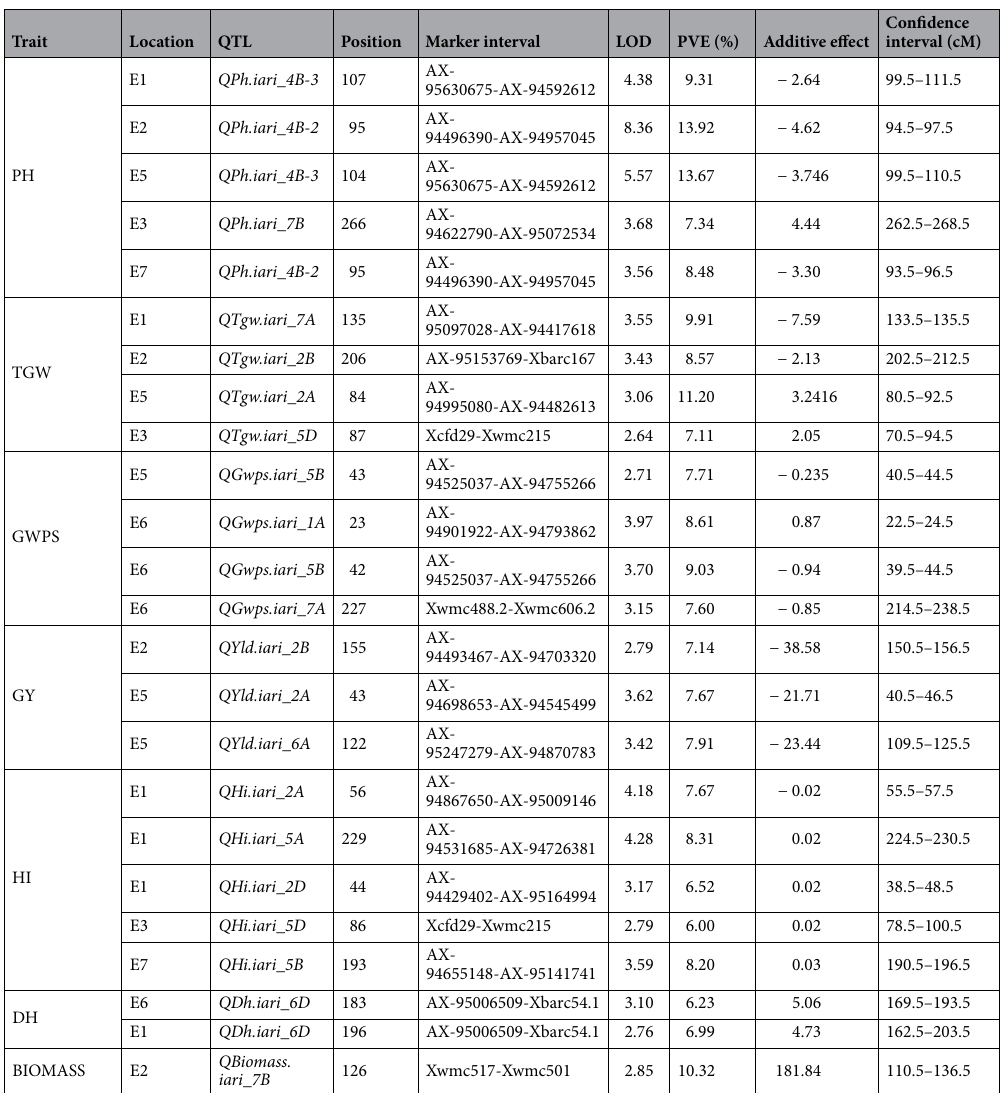
Table 2. QTLs detected for various physiological and yield component traits in the HD2733/2*C306 backcross inbred lines population. Confidence interval (cM), Position of QTL located on chromosome: as cM distance from the top of each map. LOD, A LOD threshold of 2.5 was used for declaration of QTL. PVE (%), Phenotypic variance explained by QTL. Additive effect, Positive “additive effect” indicates an increasing effect from HD2733; negative “additive effect” indicates an increasing effect from C306. Location code; E1-Delhi rainfed (2016–2017), E2-Delhi irrigated (2016–2017), E3-Indore restricted irrigation (2016–2017),